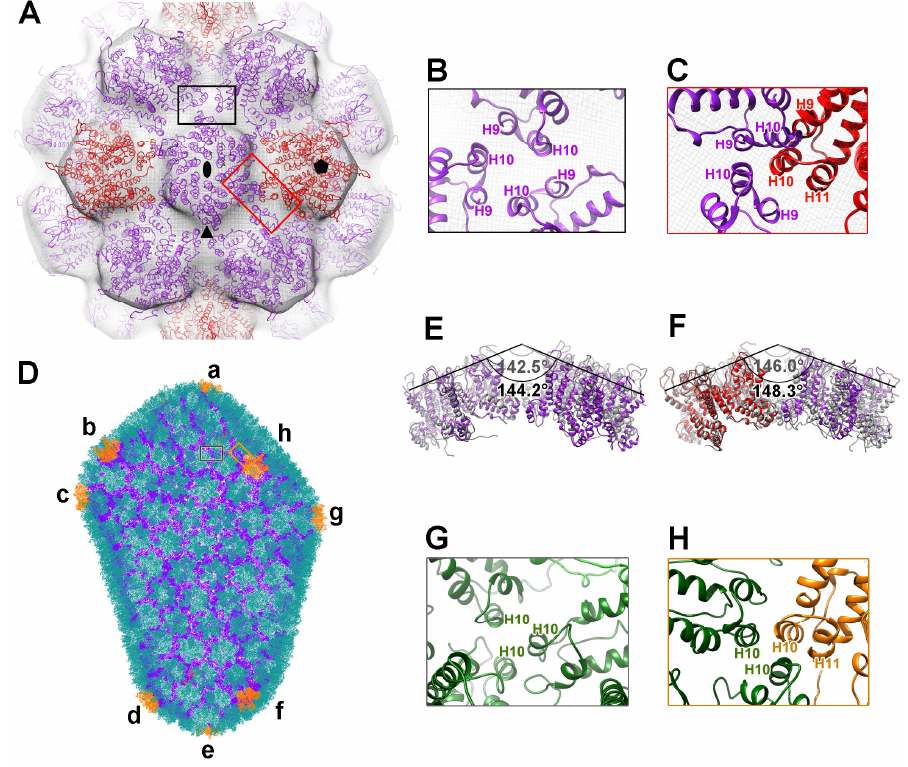
Figure 3. The models and major interactions of T = 4 CA N21C/A22C particle and fullerene capsid. ( A ) The atomic model of T = 4 CA N21C/A22C particle embedded in the semi-transparent cryo-EM density map, viewed along a two-fold axis (pentamer PDB no. 3P05, hexamer PDB no. 3H47). The pentamers are red, and the hexamers are purple. The two-, three- and five-fold symmetry axes are indicated by the black solid ellipse, triangle and pentagon, respectively. ( B and C ) Close-up views of the boxed regions in (A), showing the hexamer–hexamer (B, black box) and pentamer–hexamer (C, red box) interaction interfaces. ( D ) The atomic model of the fullerene capsid (PDB no. 3J3Q). Hexamers are green, pentamers are orange. Twelve pentamers were labelled a to l; pentamers i to l are hidden, as they are on the opposite side of the model. Refer to Figure S3 to observe all the pentamers. ( E and F ) Dihedral angles (angle between two planes defined by neighboring pentamers or hexamers) of hexamer–hexamer ( E ) and pentamer–hexamer ( F ) in the CA N21C/A22C. These dihedral angles resemble those of the pentamer labelled “h” (colored in gray). ( G and H ) Close-up views of the boxed region in ( D ), representing the interaction interfaces in the hexamer–hexamer ( G ) and pentamer–hexamer ( H